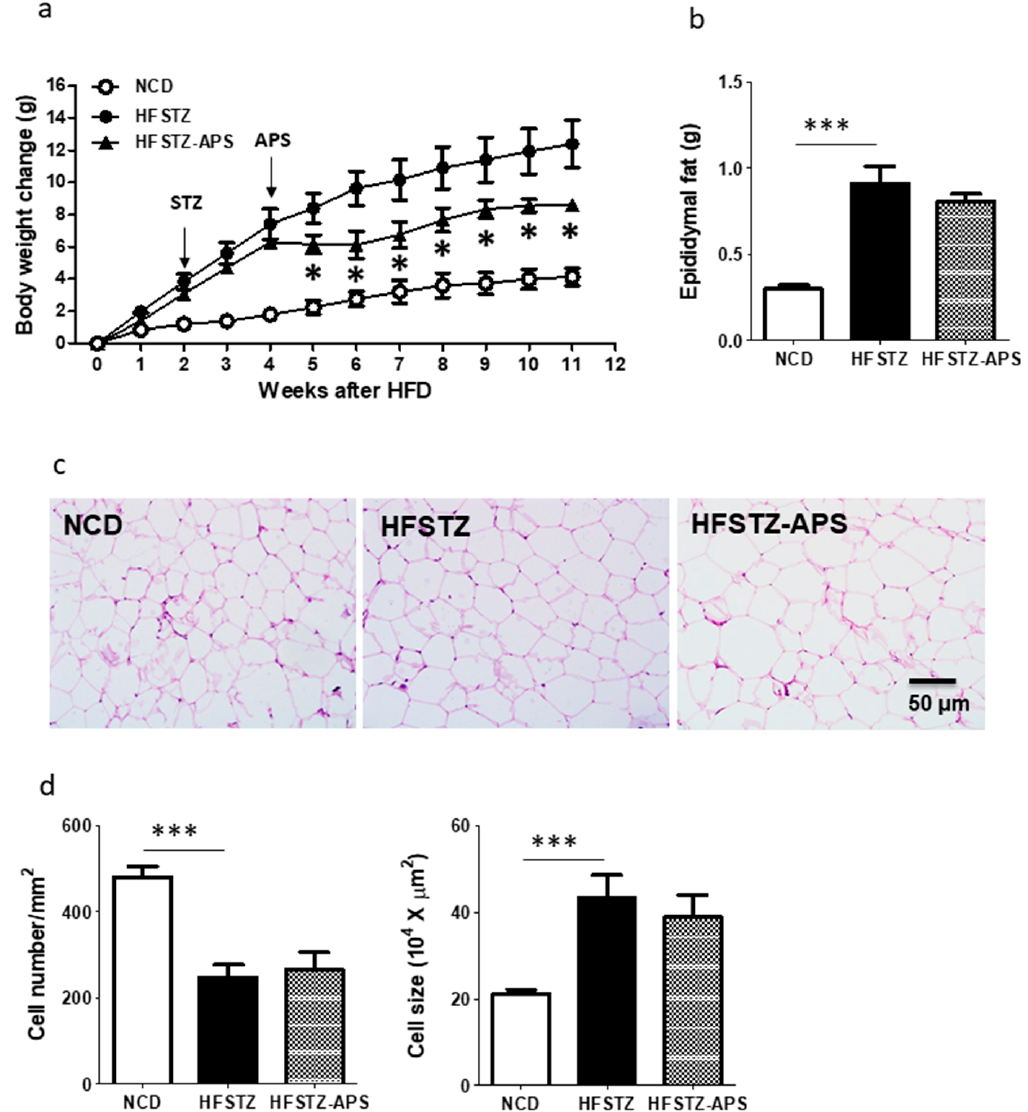
Figure 3. APS recovered the body weight increase mediated by the treatment of HFSTZ. Three groups of APP/PS1 mice: NCD ( n = 6), HFSTZ ( n = 7) or HFSTZ-APS ( n = 6) are examined. ( a ) Body weights were recorded every week; ( b ) The mass of epididymal fat tissue was determined; ( c ) Representative histological microphotographs of hematoxylinand eosin (HE)-stained epididymalfat sections were shown (scale bar, 50 µ m); ( d ) Adipocyte number and size were measured by ImageJ. Bars represent the mean ± SEM of atleast three independent experiments. Bars represent the mean ± SEM. * p < 0.01 and *** p < 0.001, significant difference from HFSTZ group.